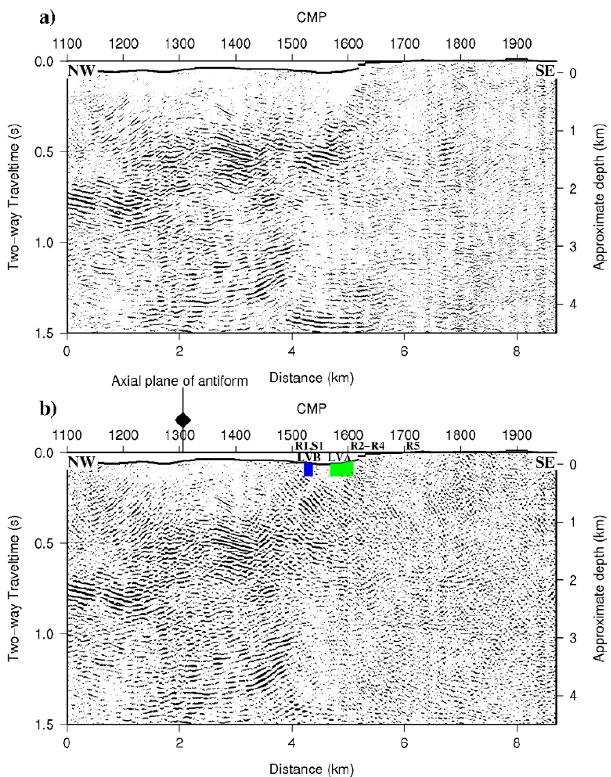
Fig. 4. (a) Final migrated stack of S.P. 2. (b) Final migrated stack of S.P. 2 merged with migrated stack using high stacking velocities. Green zone – LVA; Blue zone – LVB see text for explanation. Re- flections S1 and R1–R5 marked. Location of axial plane of antiform from geology map (Fig. 2) also marked. Elevation on top. Length to depth ratio approximately